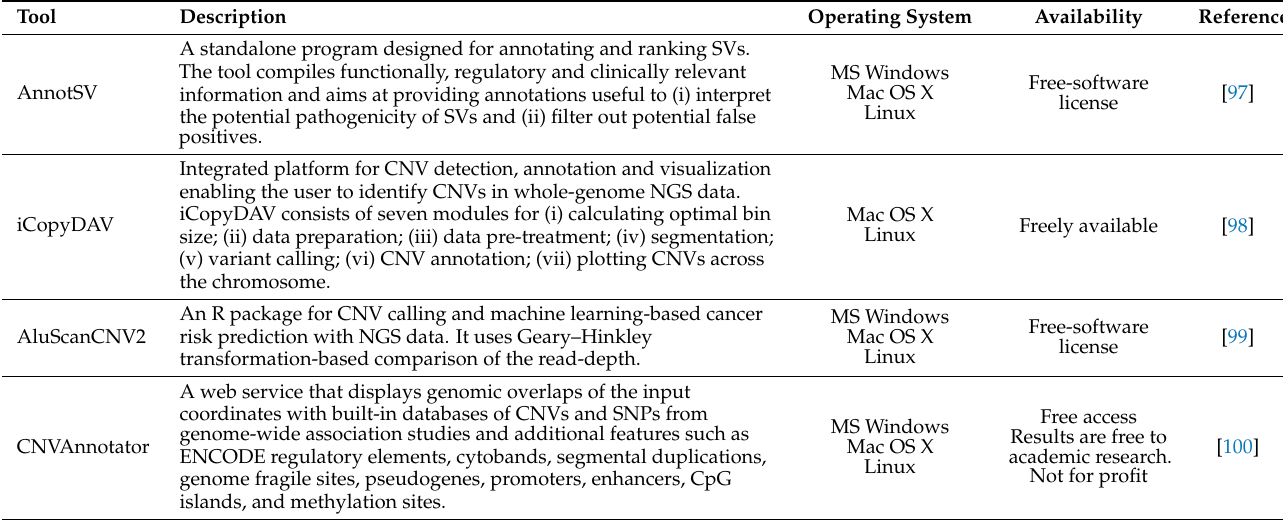
Table 2. Decision support tools for annotation and/or classification of CNVs. SV (structural variation); WGS (whole-genome sequencing); WES (whole-exome sequencing); TADs (topologically associated